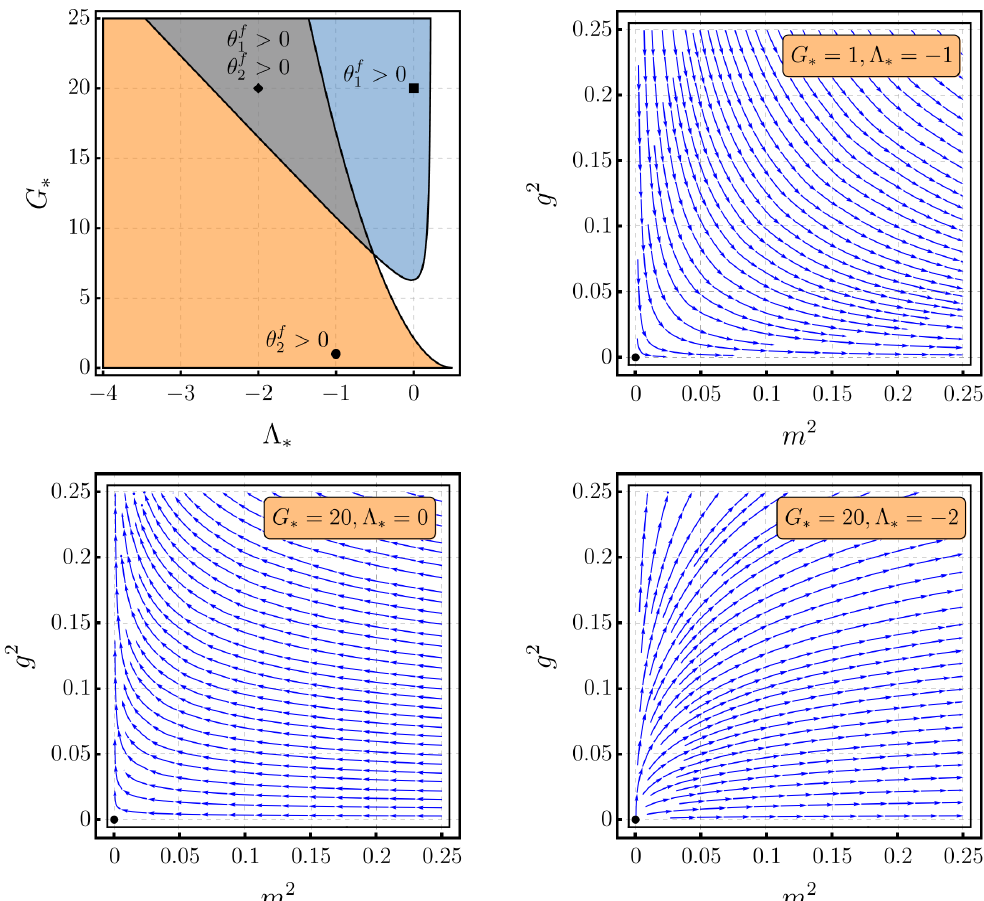
Figure 1 . In the upper left panel, we show the sign of the critical exponents associated with the free fixed point in the presence of gravity. In blue, we highlight the parameter space where θ f orange, the region where θ f > 0 . In the other three panels, we show the RG flow towards the IR in 2 the vicinity of the free fixed point for the three different regions in the upper left panel; with values for G Λ indicated by a dot (corresponding to the upper right panel), a square (corresponding to ∗ , ∗ the lower left panel) and a diamond (corresponding to the lower right